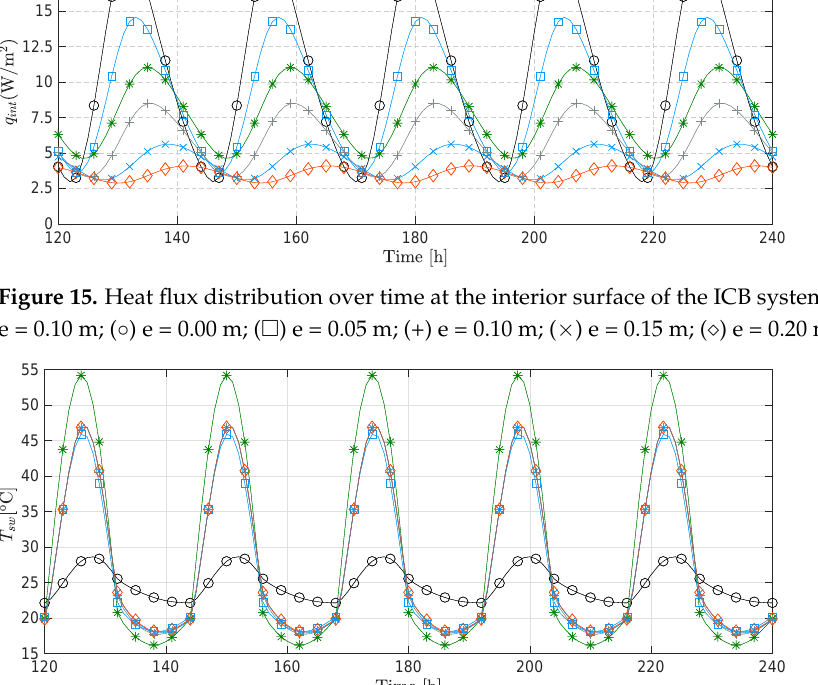
Figure 16. ICB system facade surface temperature T sw distribution over time: ( ∗ ) no canopy, e = 0.10 m; ( ◦ ) e = 0.00 m; ( (cid:3) ) e = 0.05 m; (+) e = 0.10 m; ( × ) e = 0.15 m; ( (cid:5) ) e = 0.20